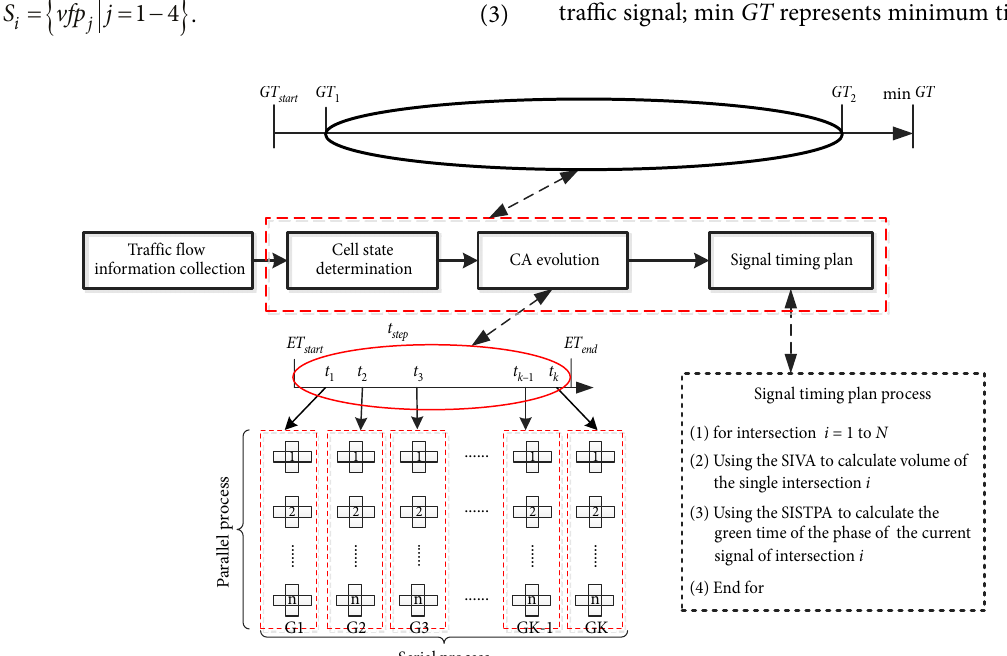
Fig. 3. The process of urban traffic signal adaptive